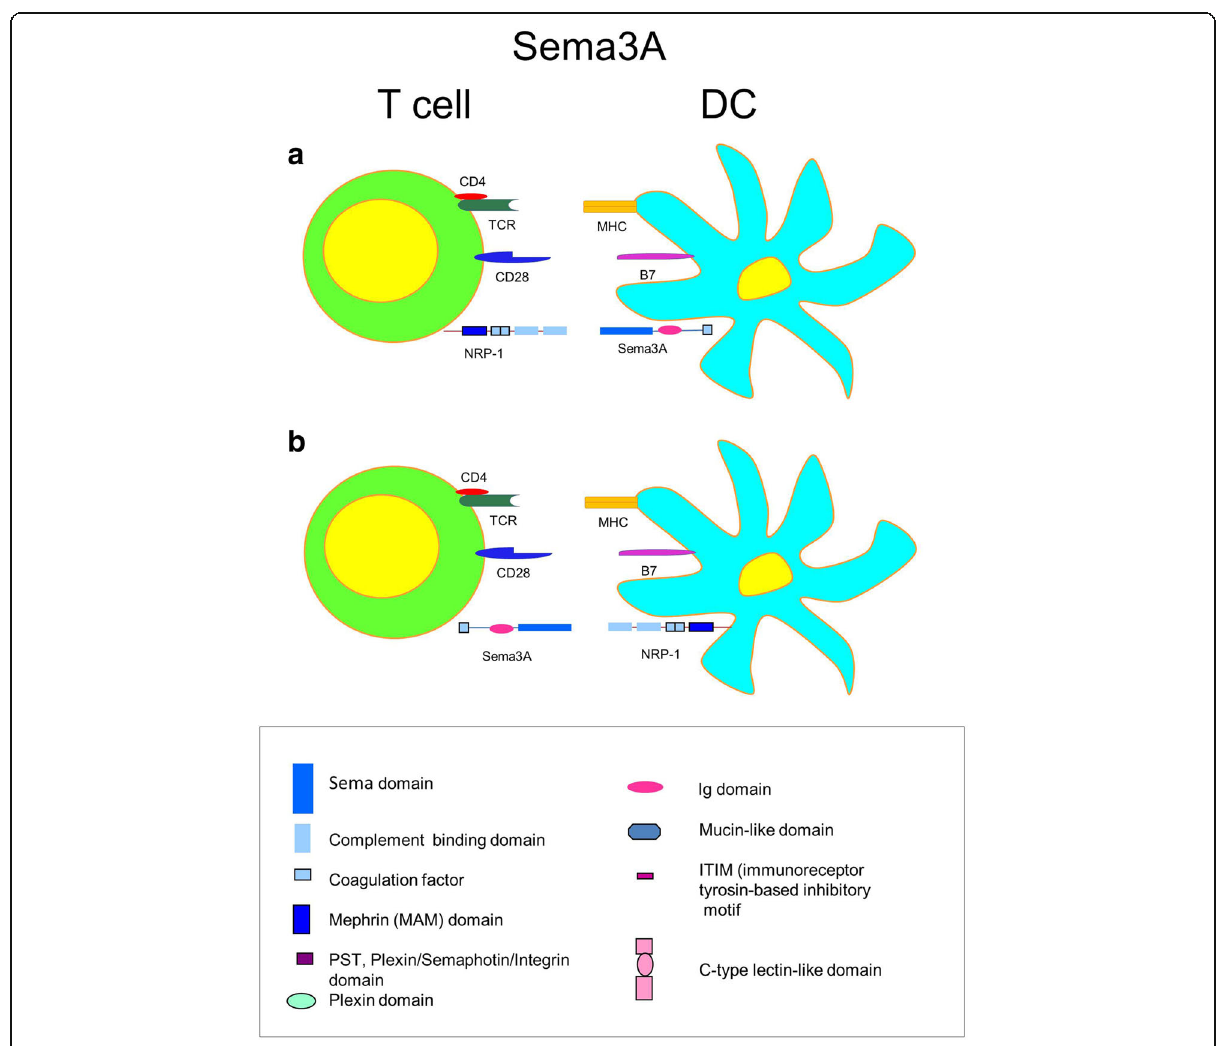
Fig. 1 Sema3A in DC – T cell crosstalk: a Sema3A inhibits T cell activation. Low constitutive levels of Sema3A on DC are upregulated with cell activation. DC surface-expressed and soluble Sema3A inhibit T cell proliferation presumably acting through NRP-1. b Sema3A inhibits DC activa- tion and chemotaxis. Inducible T cell-expressed and soluble Sema3A use NRP-1 and NRP-2 as ligand-binding receptors and NRP-associated Plexin A1 and A2 as signaling receptors to regulate DC activation and